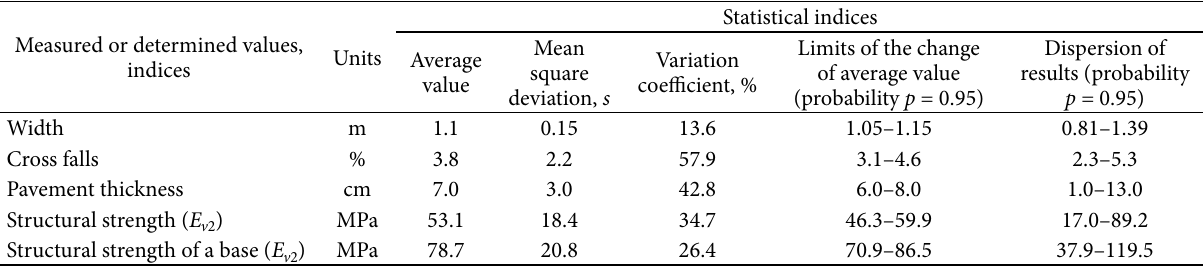
Table 1. Data of the investigation statistical evaluation of the shoulders on low-volume roads (Vorobjovas, Žilionienė 2008) Measured or determined values,